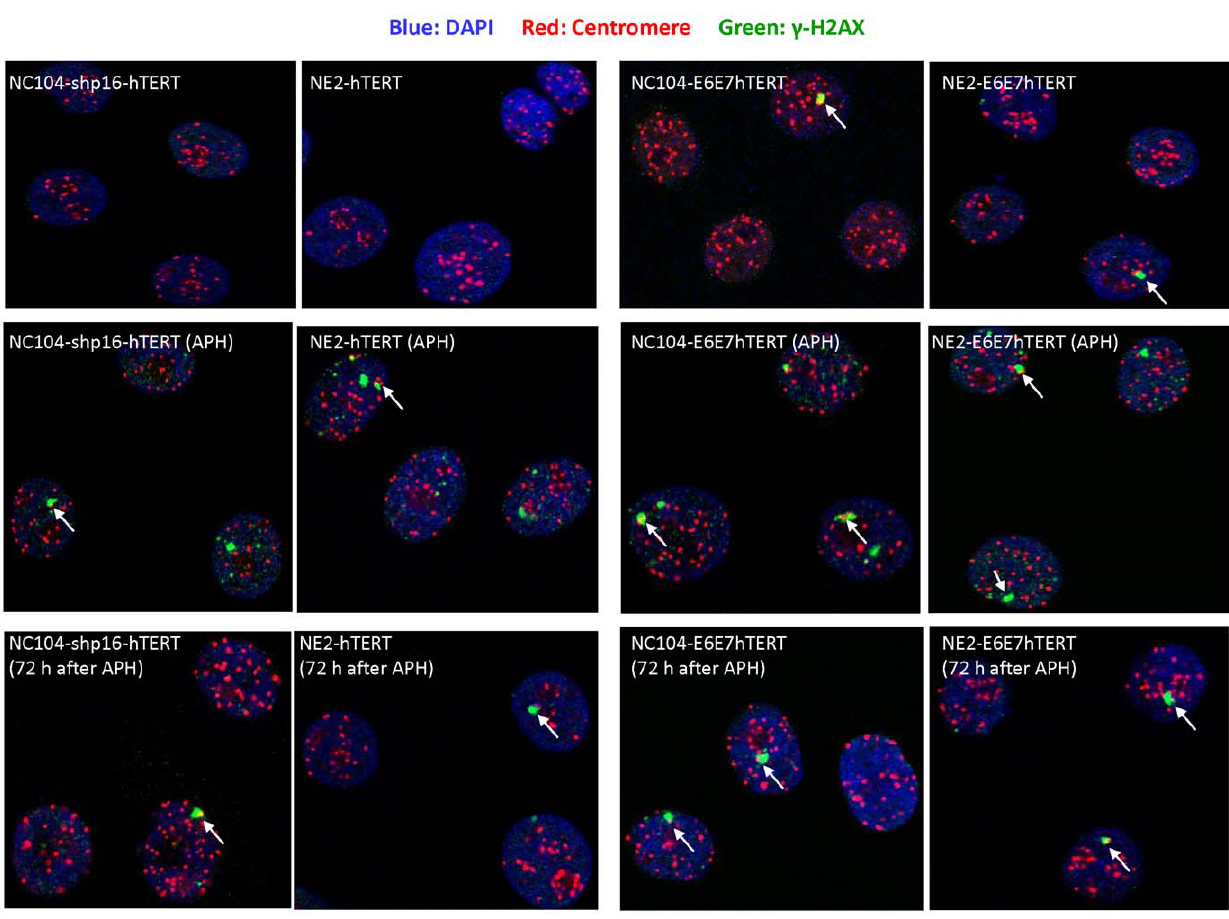
Figure 6. Immunofluorescene staining of centromeres and c -H2AX. Typical examples of co-immunostaning of centromeres (red) and c -H2AX (green). DNA was stained blue. Arrows indicate the large c -H2AX foci juxtaposed to centromeres.